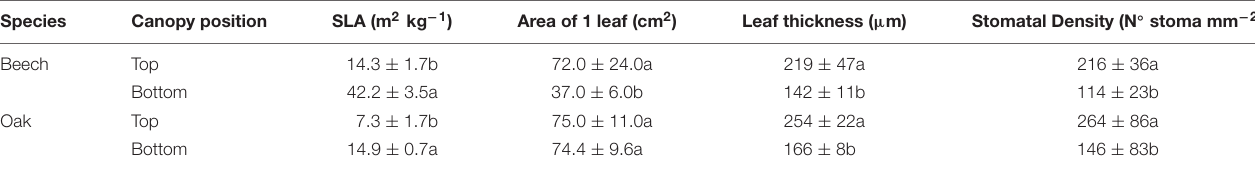
TABLE 1 | Specific leaf area (SLA), area of a single leaf, thickness and stomatal density of beech and sessile oak leaves collected from upper (top) or lower (bottom) tree canopy positions. Species